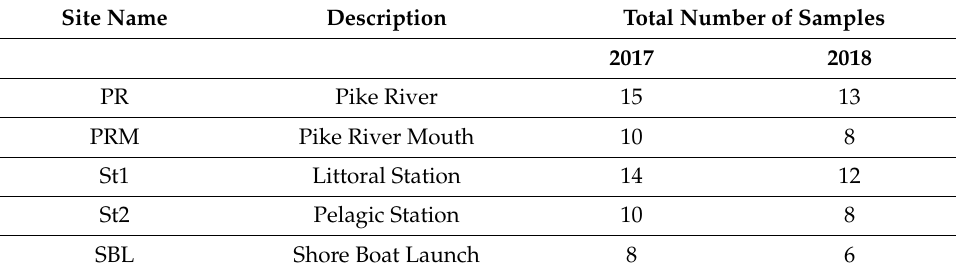
Table 1. Total number of samples taken in 2017 and